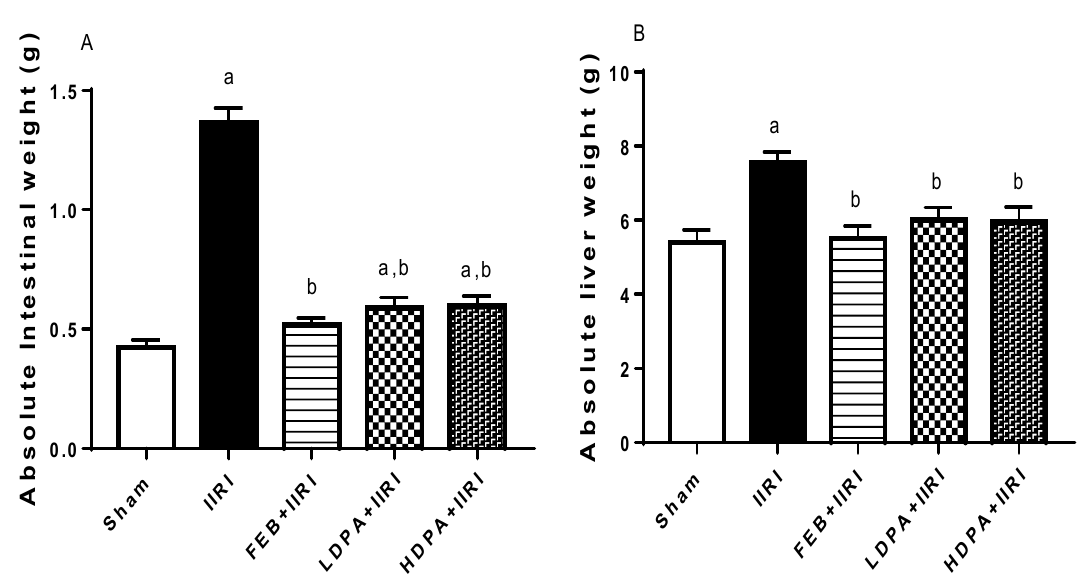
Figure 2. Effect of intestinal ischemia/reperfusion (I/R) and methanolic Phyllanthus amarus leaf extract on intestinal and hepatic weight. FEB, LDPA, and HDPA significantly reduced IIRI-induced increase in absolute intestinal weight ( A ) and absolute hepatic weight ( B ). IIRI: intestinal ischemia/reperfusion injury, FEB: febuxostat, LDPA: low-dose Phyllanthus amarus , HDPA: high-dose Phyllanthus amarus , a p < 0.05 versus sham, b p < 0.05 versus IIRI. Values represent the mean for ten replicates ± the standard deviation.